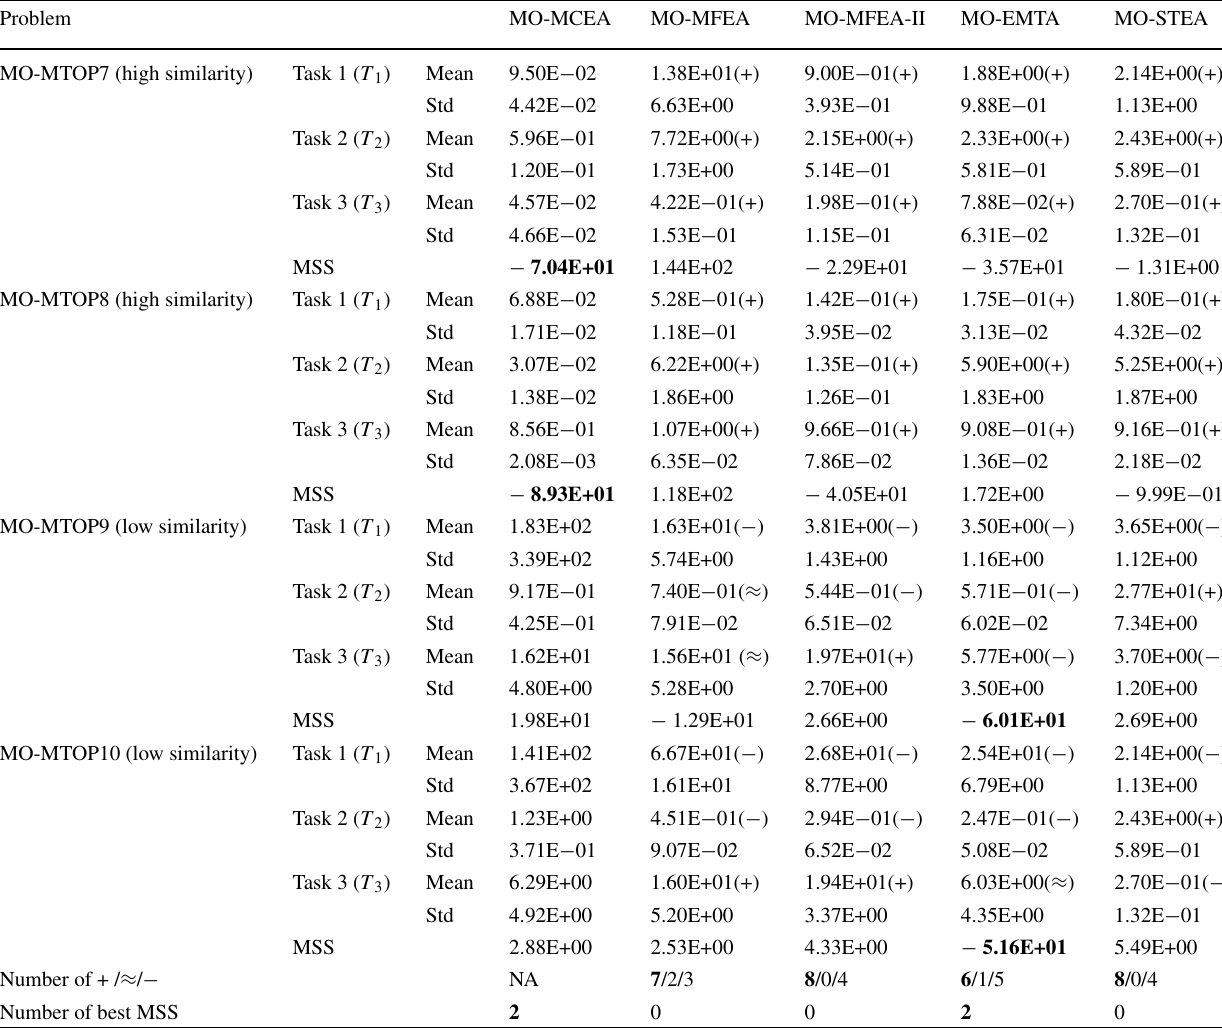
Table 6 Comparisons between the proposed MO-MCEA and state-of-the-art algorithms on MO-MTOPs with three tasks Problem MO-MTOP7 (high similarity)